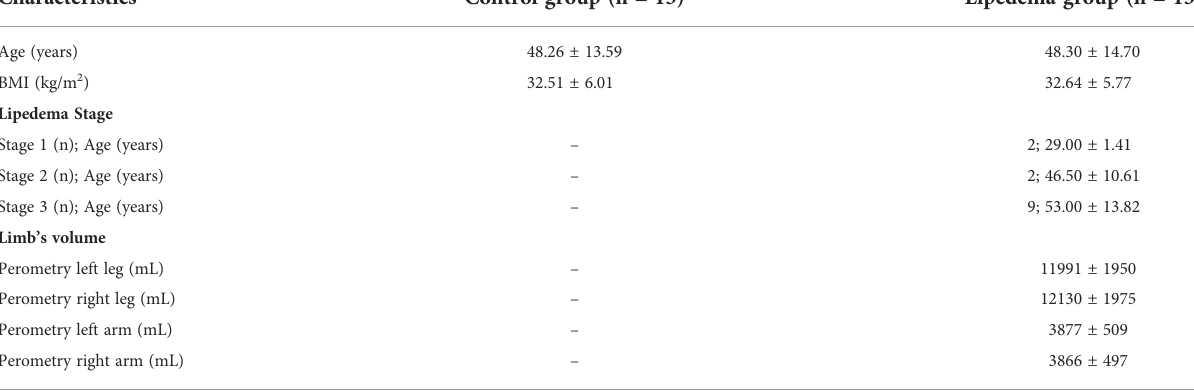
TABLE 1 Patient ’ s